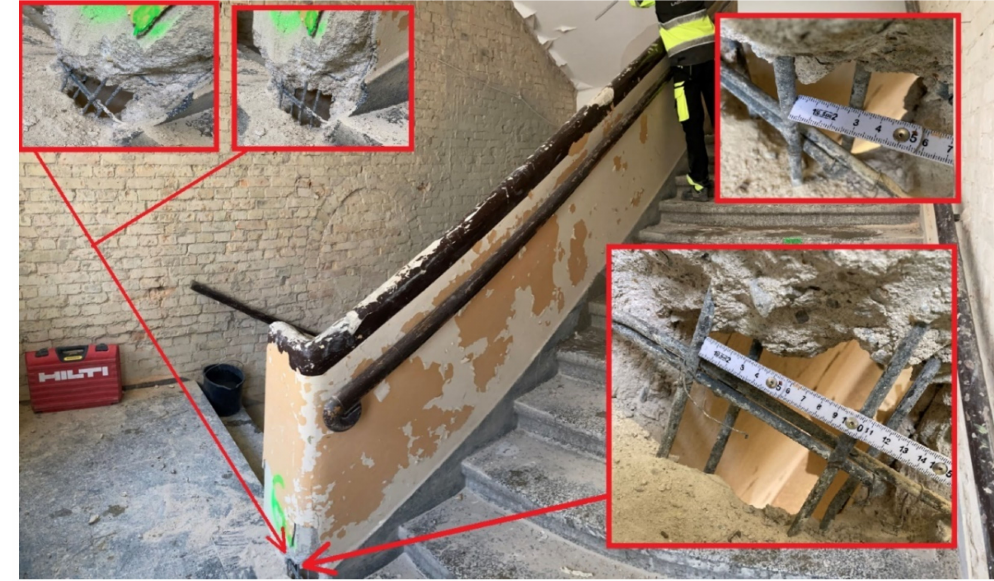
Figure 3. A view of a staircase with a sample 8